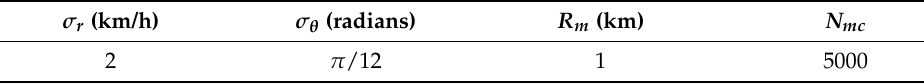
Table 2. Parameters used in the